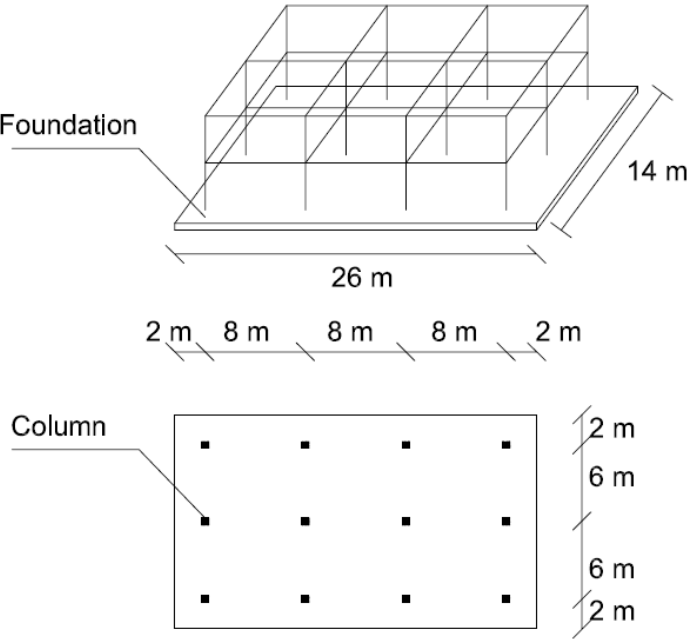
Figure 1. 3D view of the numerical model (Model B1, B2 and B3). Soil S: Infill soil (Yellow); Soil F: Foundation soil (Blue).